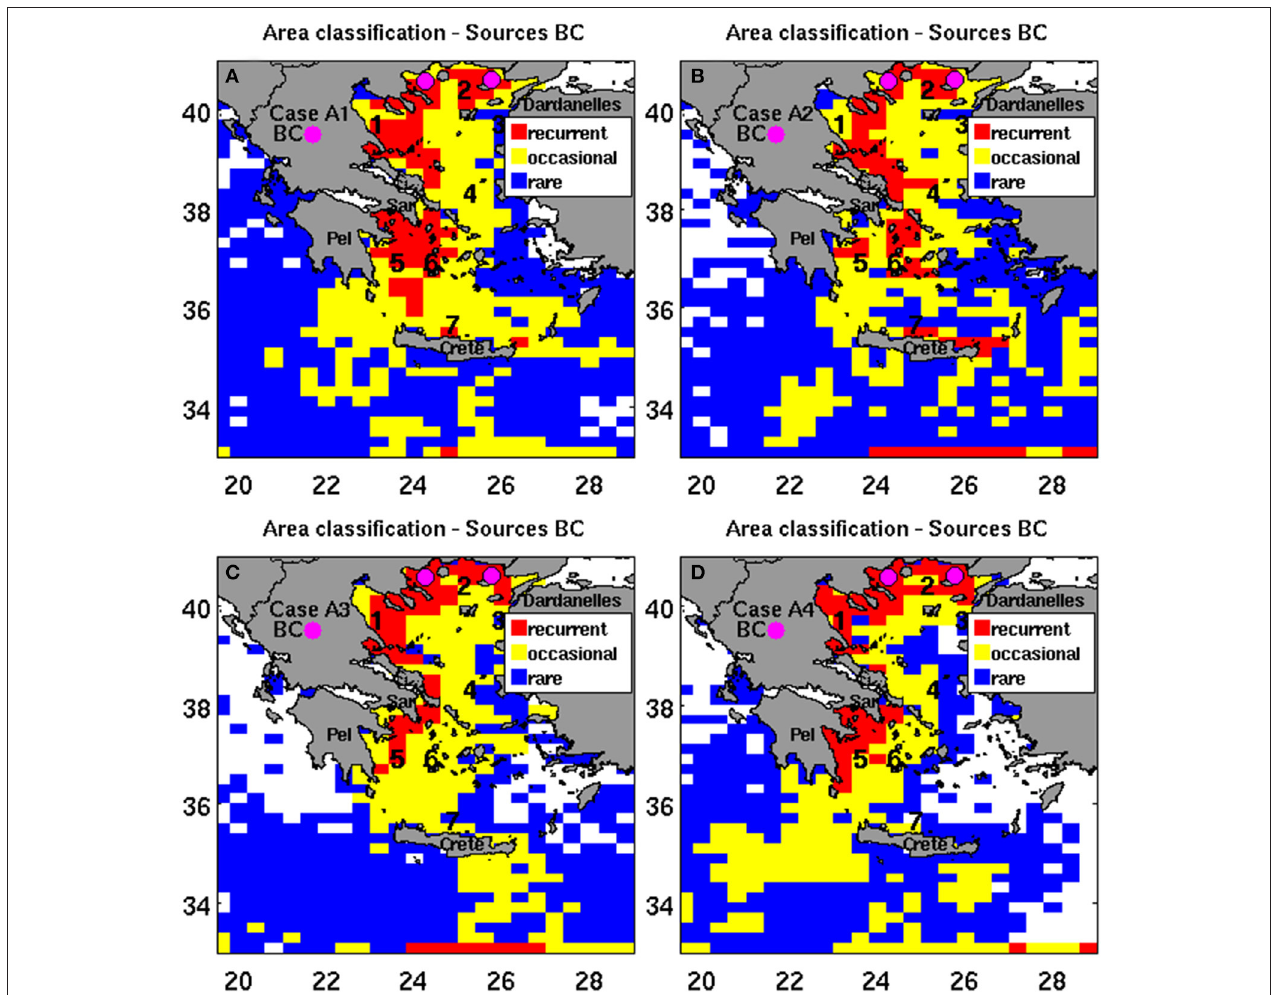
FIGURE 7 | Area classification maps of floating litter particles originated from Source regions B, C (North Aegean) in Cases (A) A1, (B) A2, (C) A3, and (D) A4. Magenta dot points indicate the source regions B,C.